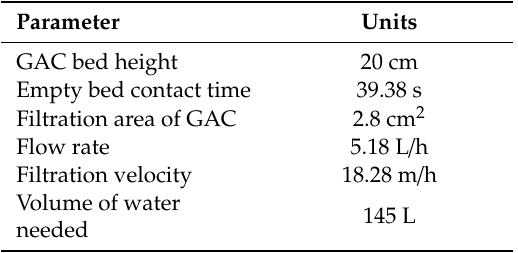
Table 2. Operational parameters of the adsorption lab-scale preliminary